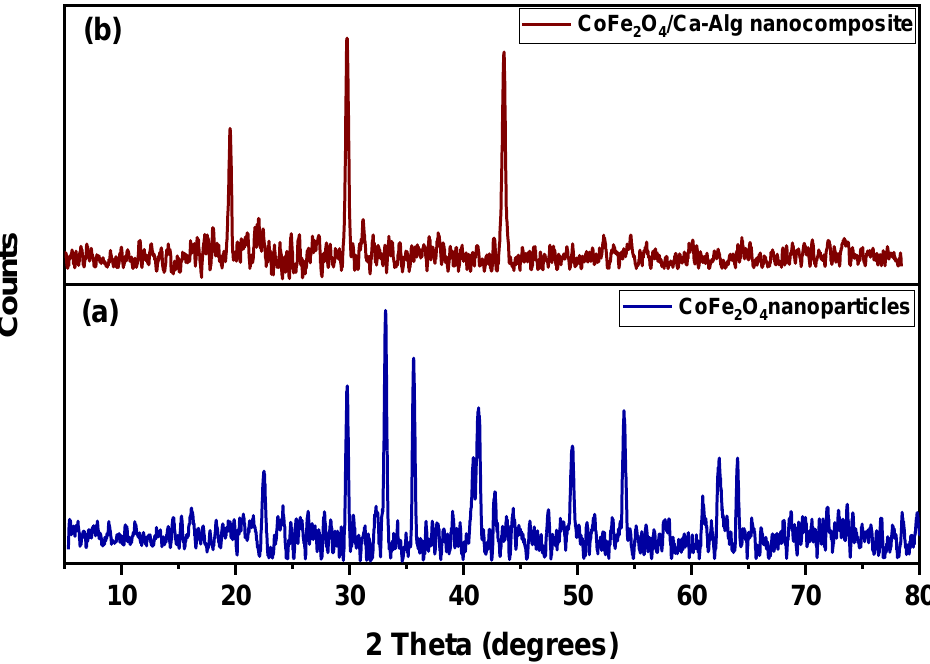
Figure 1. Shows the XRD patterns of ( a ) green synthesized CoFe 2 O 4 nanoparticles and ( b ) CoFe 2 O 4 /Ca-Alg